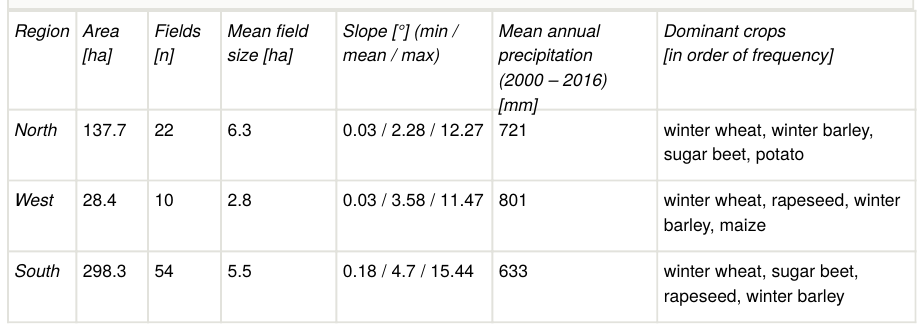
Properties of the monitored fi elds in Lower Saxony, grouped by